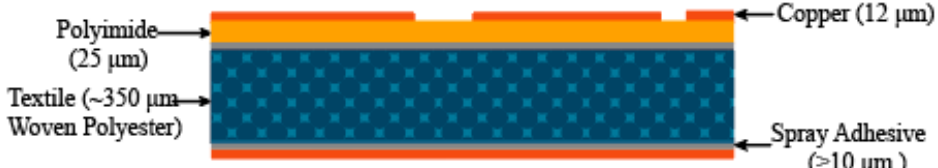
Figure 3. Cross-section of assembled structure on textile.